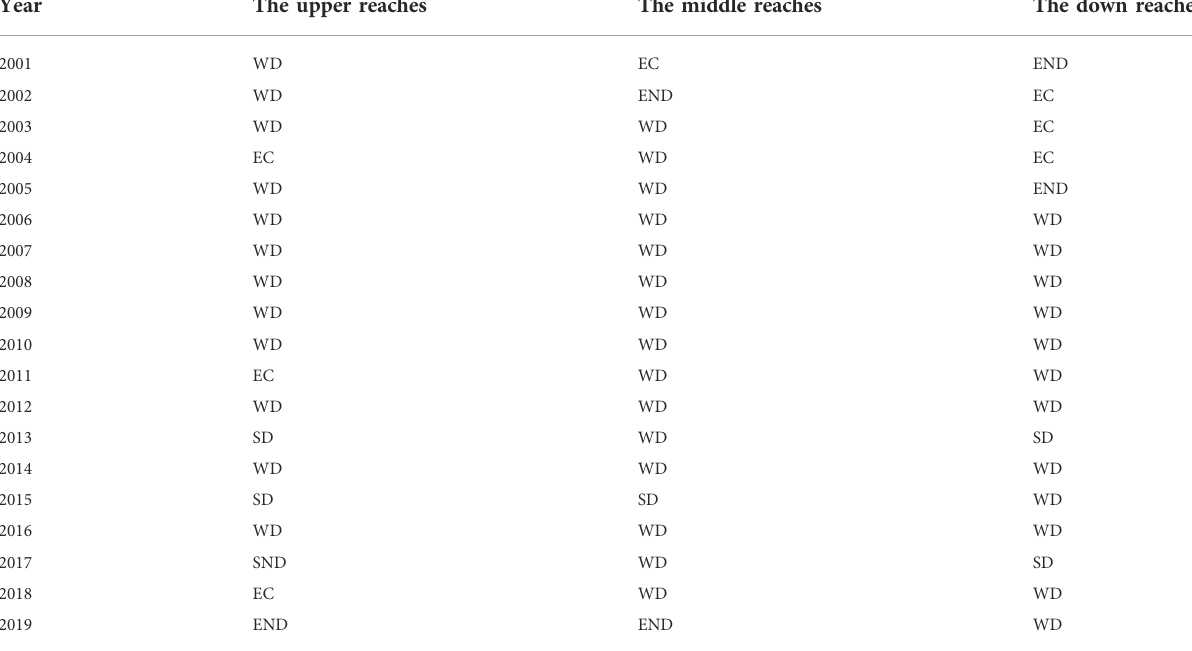
TABLE 6 Decoupling of carbon emissions and economic growth in various regions of the YRB. Year The upper reaches The middle